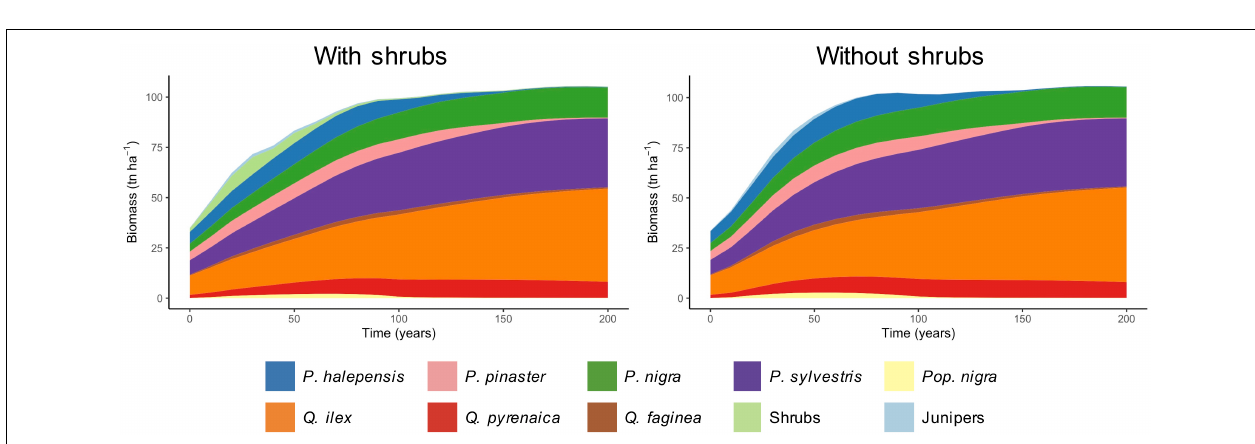
FIGURE 6 | Average biomass of species through time for the whole landscape. Note that Junipers ( J. communis and J. oxycedrus ) and shrub communities (short, medium, and tall) have been grouped